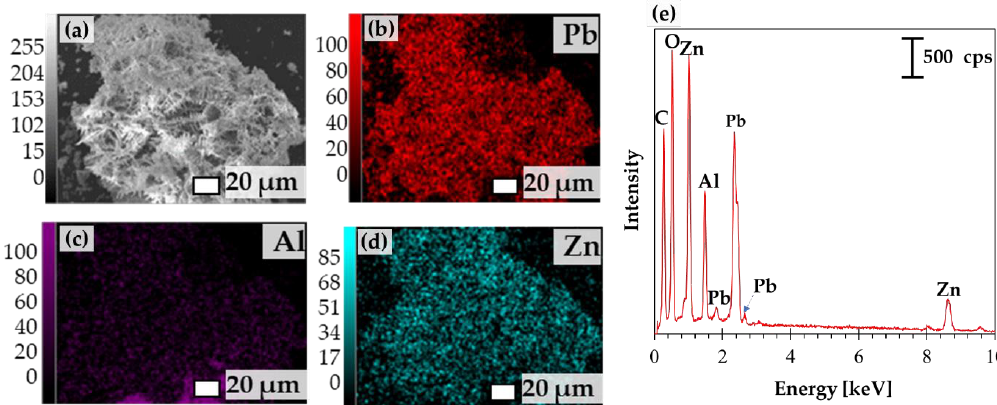
Figure 7. Amount of Pb and Zn cemented out using ZVAl in model experiments under ( a ) the simulated acidic chloride and ( b ) simulated alkaline solutions.